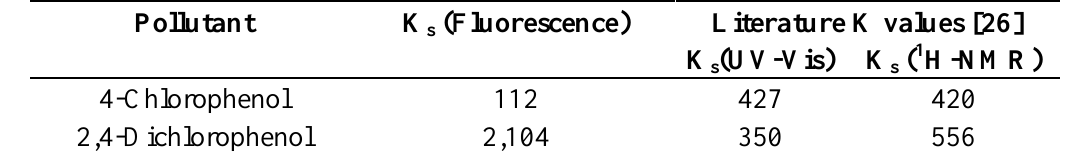
Table 2. Stability